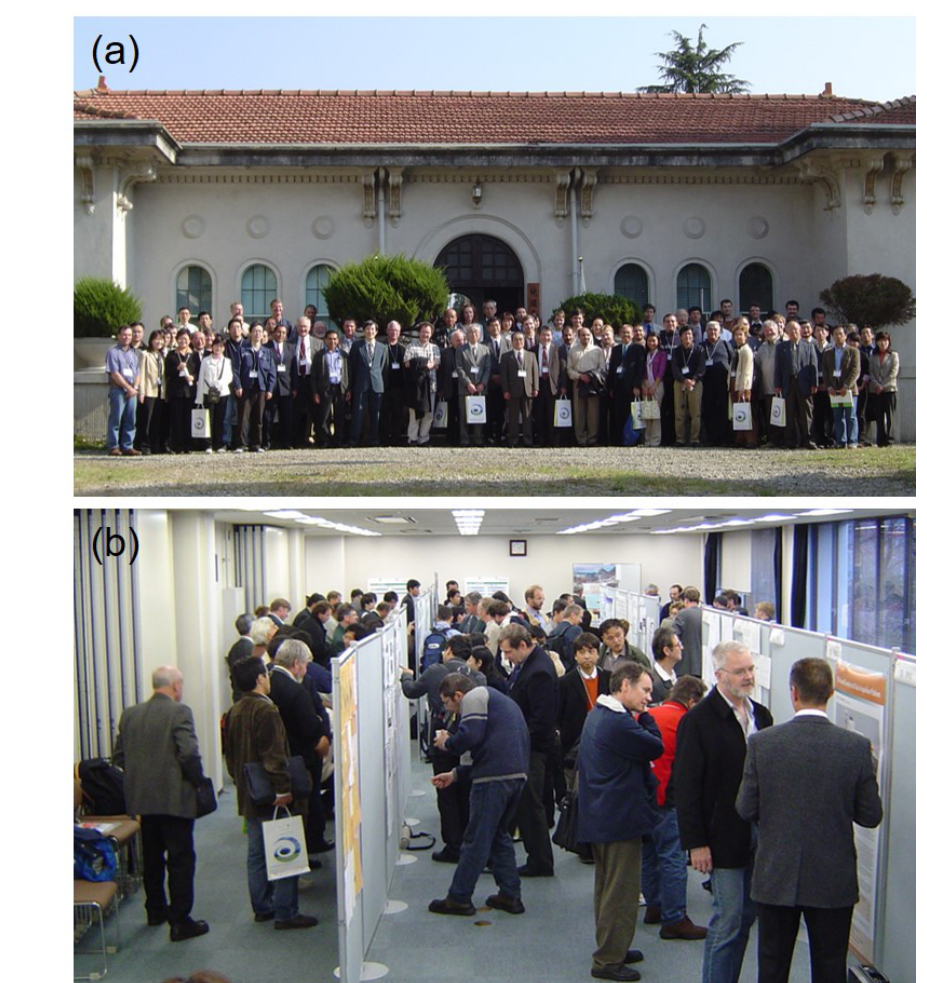
Figure 30. The 11th IAGA Workshop on Geomagnetic Observatory Instruments, Data Acquisition and Processing held on 9–17 Novem- ber 2004. The measurement session was held at Kakioka (a) , while the scientific session was held at Tsukuba (b) (photo supplied by Kakioka Magnetic